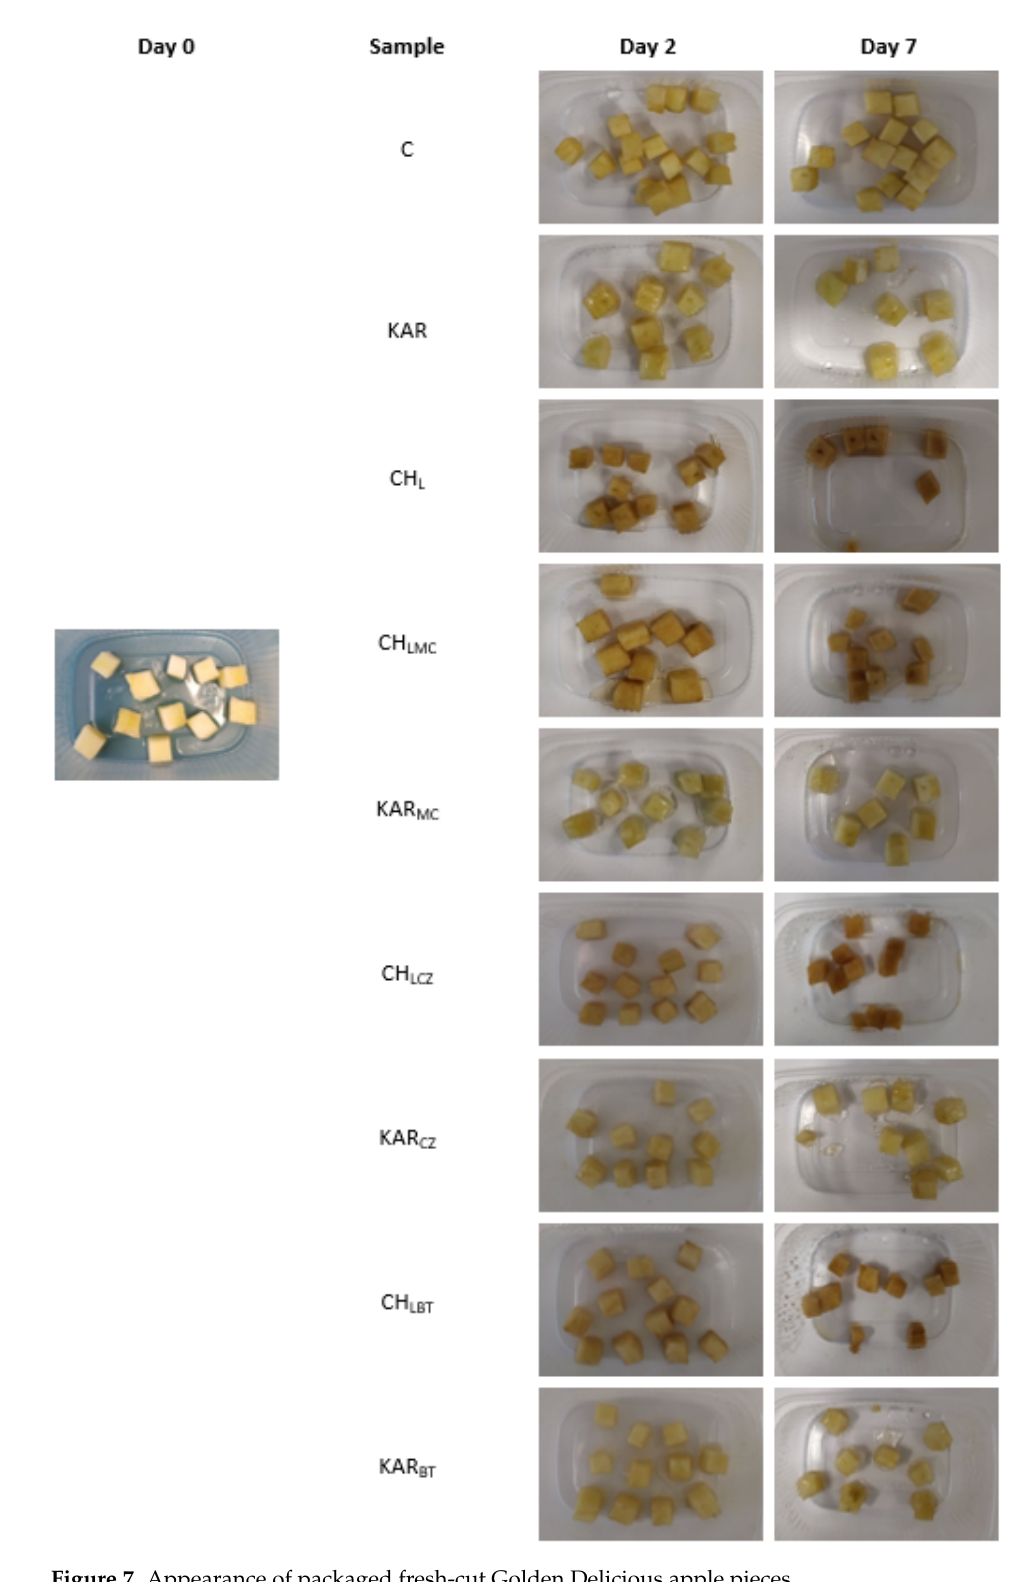
Figure 7. Appearance of packaged fresh-cut Golden Delicious apple pieces. Antioxidant activity of fresh-cut apple pieces packed in experimentally produced edible films (in refrigerator for 7 days) is shown in Tables 4 and 5. Fresh-cut green apple samples had the highest antioxidant activity determined by FRAP method; after 2 days of storage with the samples immersed in KAR film, the result was statistically